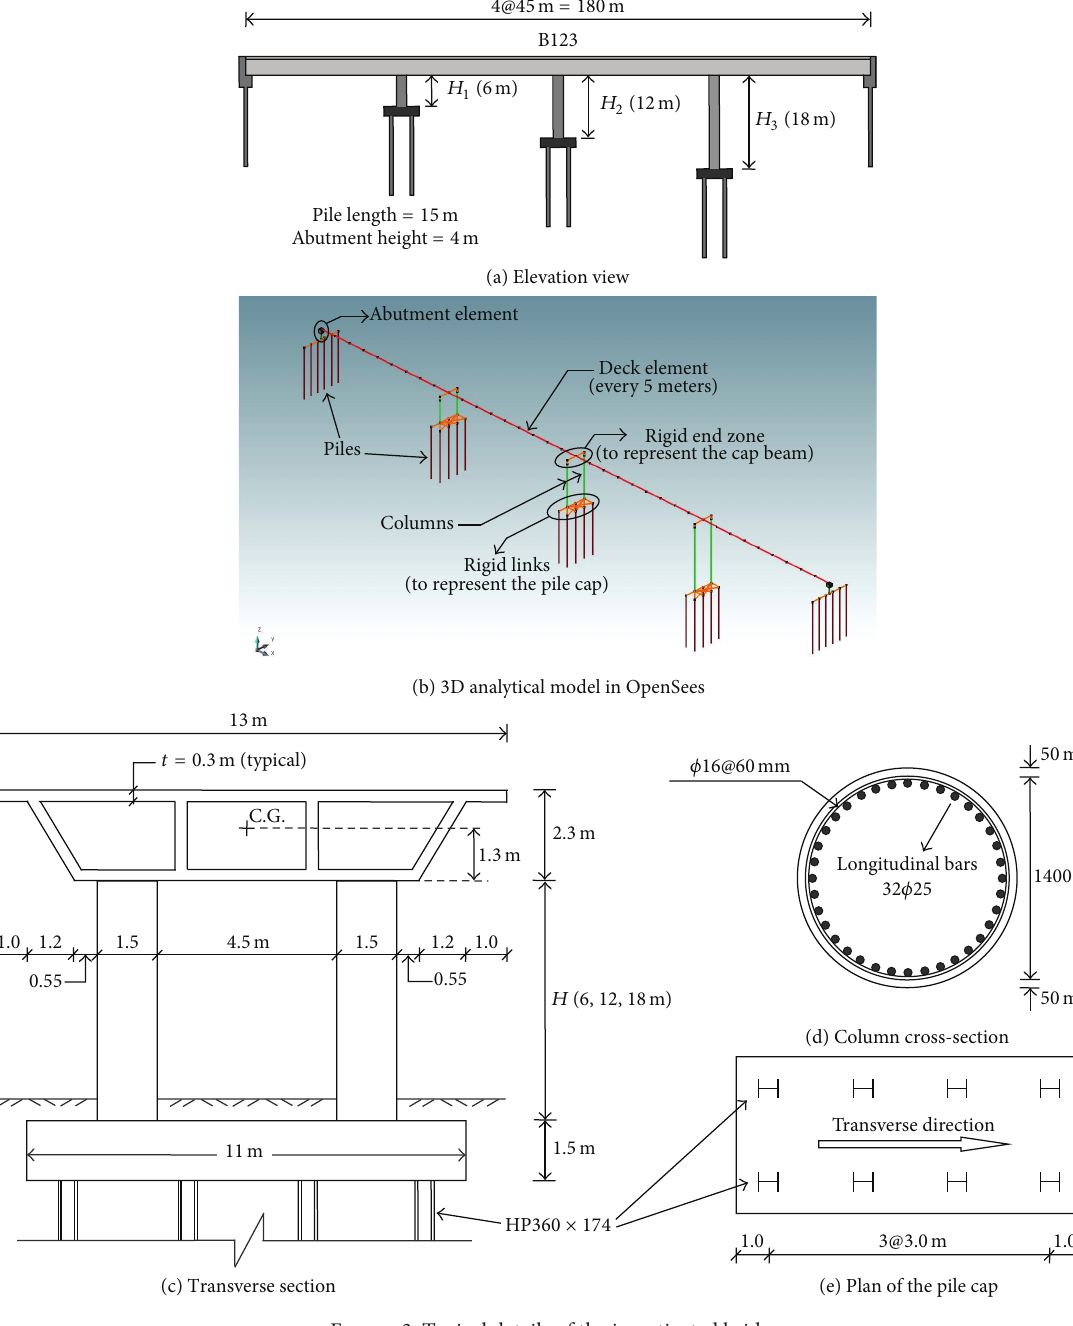
Figure 3: Typical details of the investigated